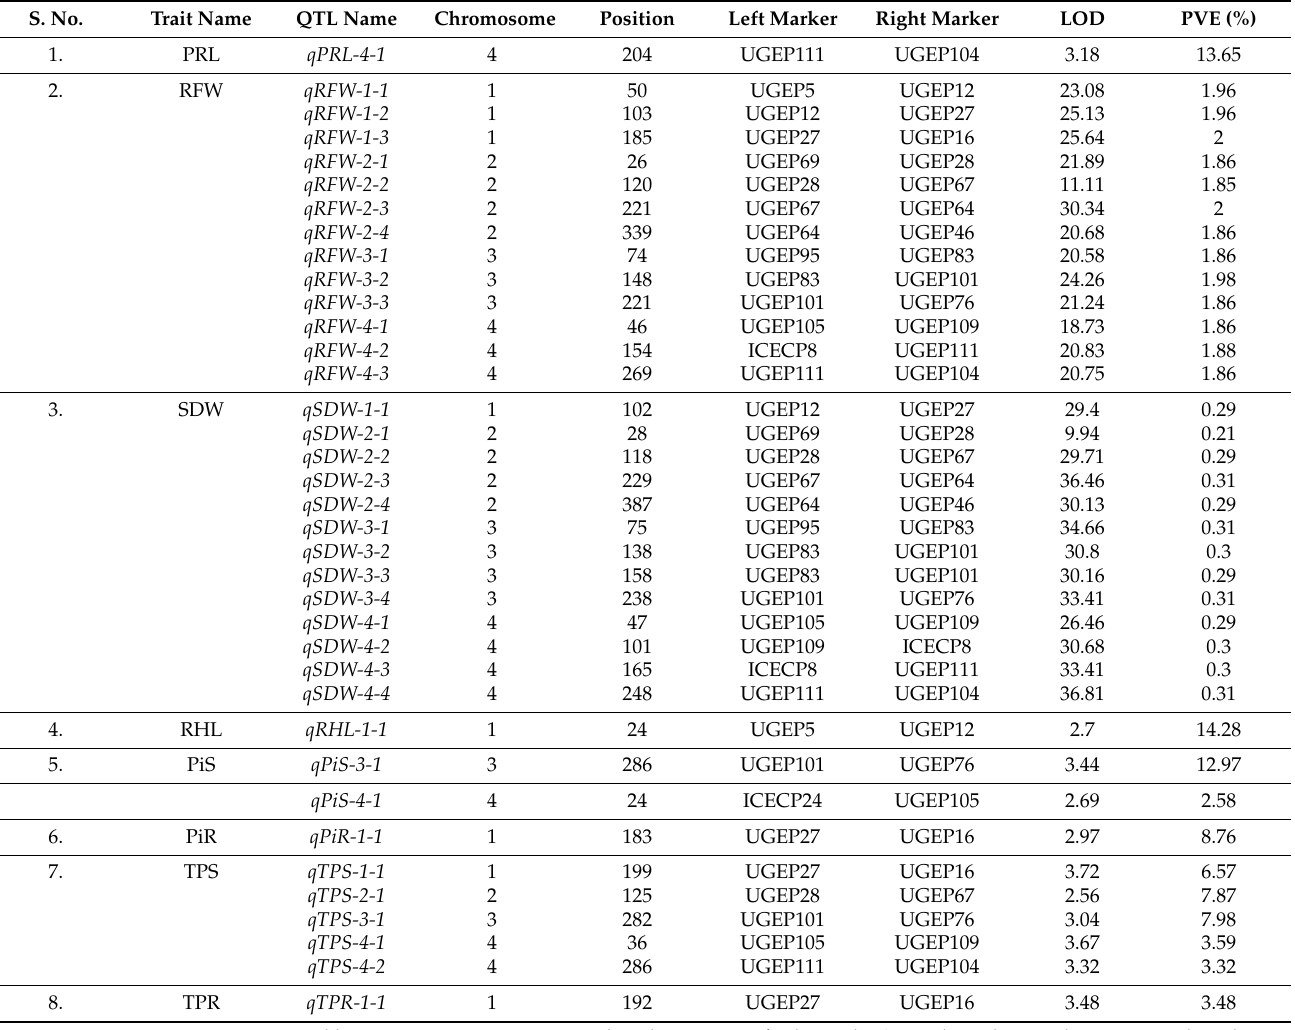
Table 5. Putative QTL identified for various agro-morphological and P-content traits via linkage mapping, using 100 RILs derived from IE-2606 and PR-202